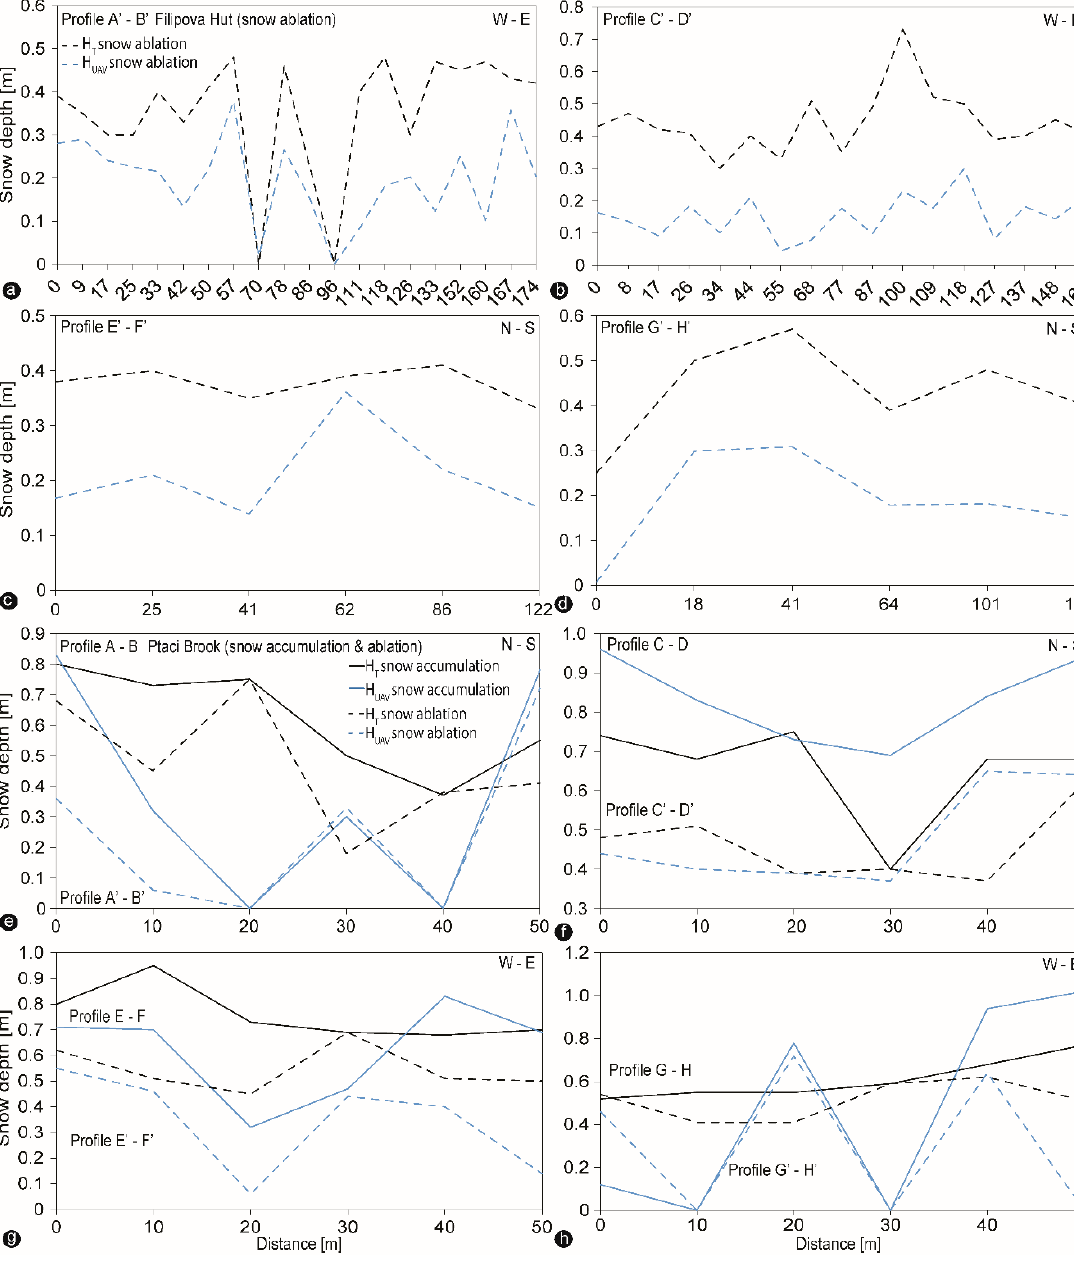
Figure 8. ( a – d ) Snow depth profiles between estimated H UAV measurements and manual probing H T across the open area in West-East and North-South direction during snow ablation (profiles A’-B’ to G’-H’). ( e – h ) Snow depth profiles between estimated H UAV measurements and manual probing H T across the forest site in West-East and North-South direction during snow accumulation (profiles A-B to G-H) and ablation (profiles A’-B’ to G’-H’).